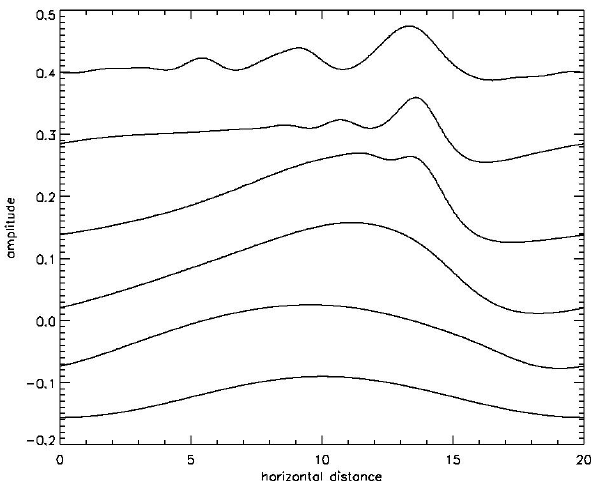
Fig. 4. As in Fig. 3 for initialization with a cosine ducting profile in a shallow domain. Traces are taken at times 0, 45, 101, 135, 178, 204.